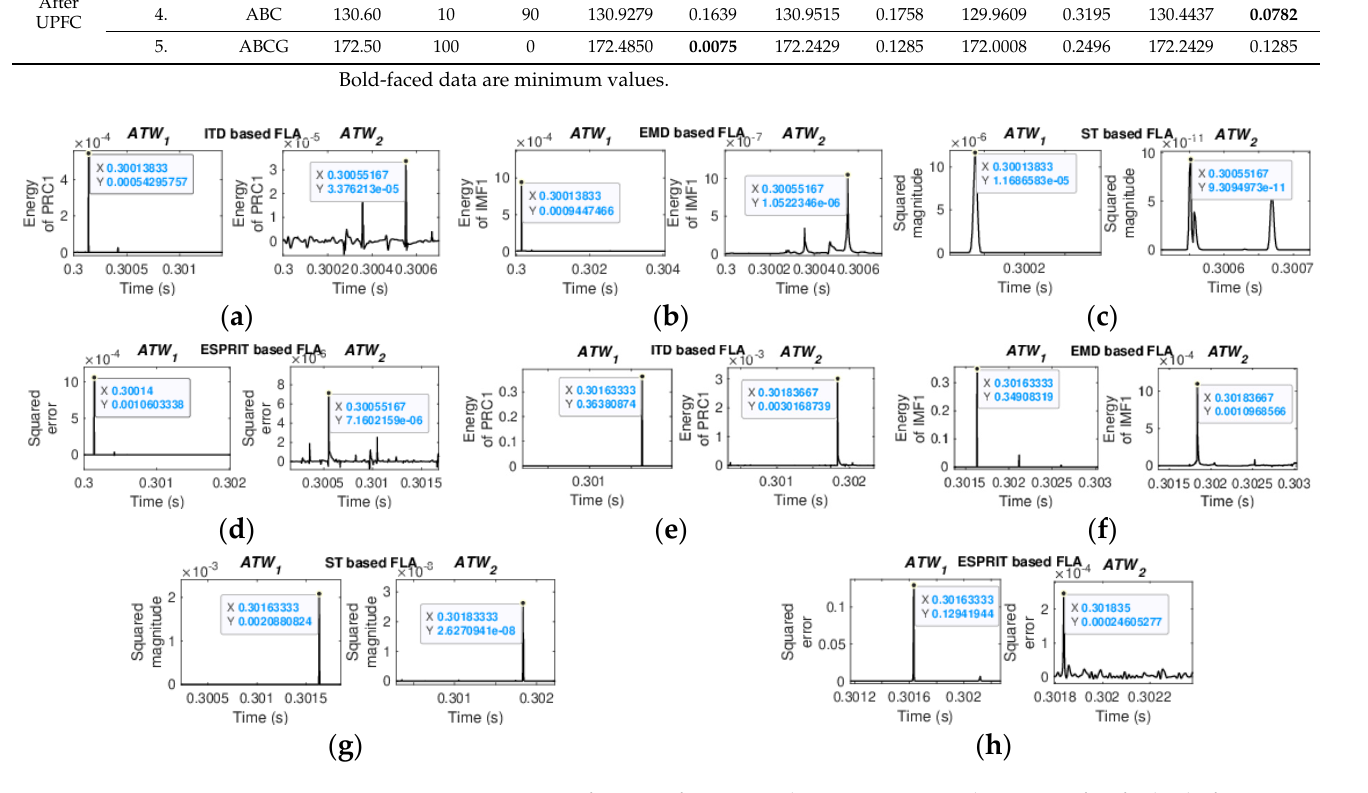
Figure 8. Estimation of ATWs for series-shunt-compensated systems for faults before UPFC. ( a – d ) Estimated ATWs for Scenario 1. ( e – h ) Estimated ATWs for Scenario 2.